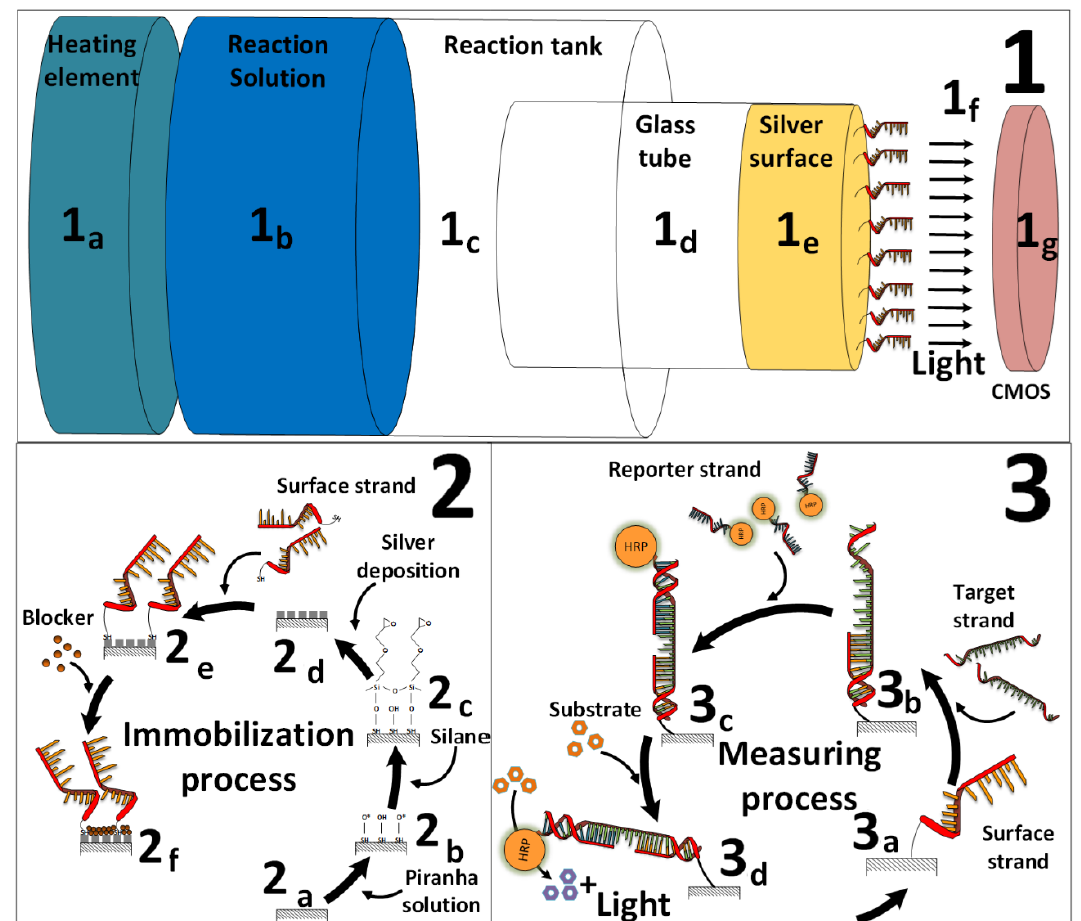
Figure 1. Schematic presentation of the CMOS-based biosensor. ( 1 ) Different sections of the complementary metal-oxide-semiconductor (CMOS)-based biosensor platform: ( 1a ) heating element for the silver-deposition reaction; ( 1b ) silver reaction solution that is used to polymerize the silver layer above the glass surface; ( 1c ) reaction tank where the polymerization reaction occurs; ( 1d ) glass tube where the deposition and measurement processes occur; ( 1e ) silver surface nanolayer with immobilized surface DNA strands; ( 1f ) horseradish peroxidase (HRP) enzymatic reaction produces a measurable light signal, amplified with metal-enhanced phenomenon (MEF); ( 1g ) CMOS photodetector that is coupled near the light signal from positive samples and transforms it into measurable electrical current. ( 2 ) The DNA immobilization process onto the glass surface: ( 2a ) unmodified glass surface; ( 2b ) activation with piranha solution; ( 2c ) silanization; ( 2d ) nucleation points for further silver deposition; ( 2e ) immobilization of surface DNA strands; ( 2f ) blocking agent (skim milk or bovine serum albumin (BSA)). ( 3 ) The measurement process where the surface DNA strand is immobilized onto the silver-deposited glass: ( 3a ) exposure to the target strand; ( 3b ) exposure to the reporter strand that is linked to HRP; ( 3c ) the strands specifically anneal into one complex; ( 3d ) addition of substrate ((1:1) luminol: H 2 O 2 ( v / v )) produces a measurable light signal.